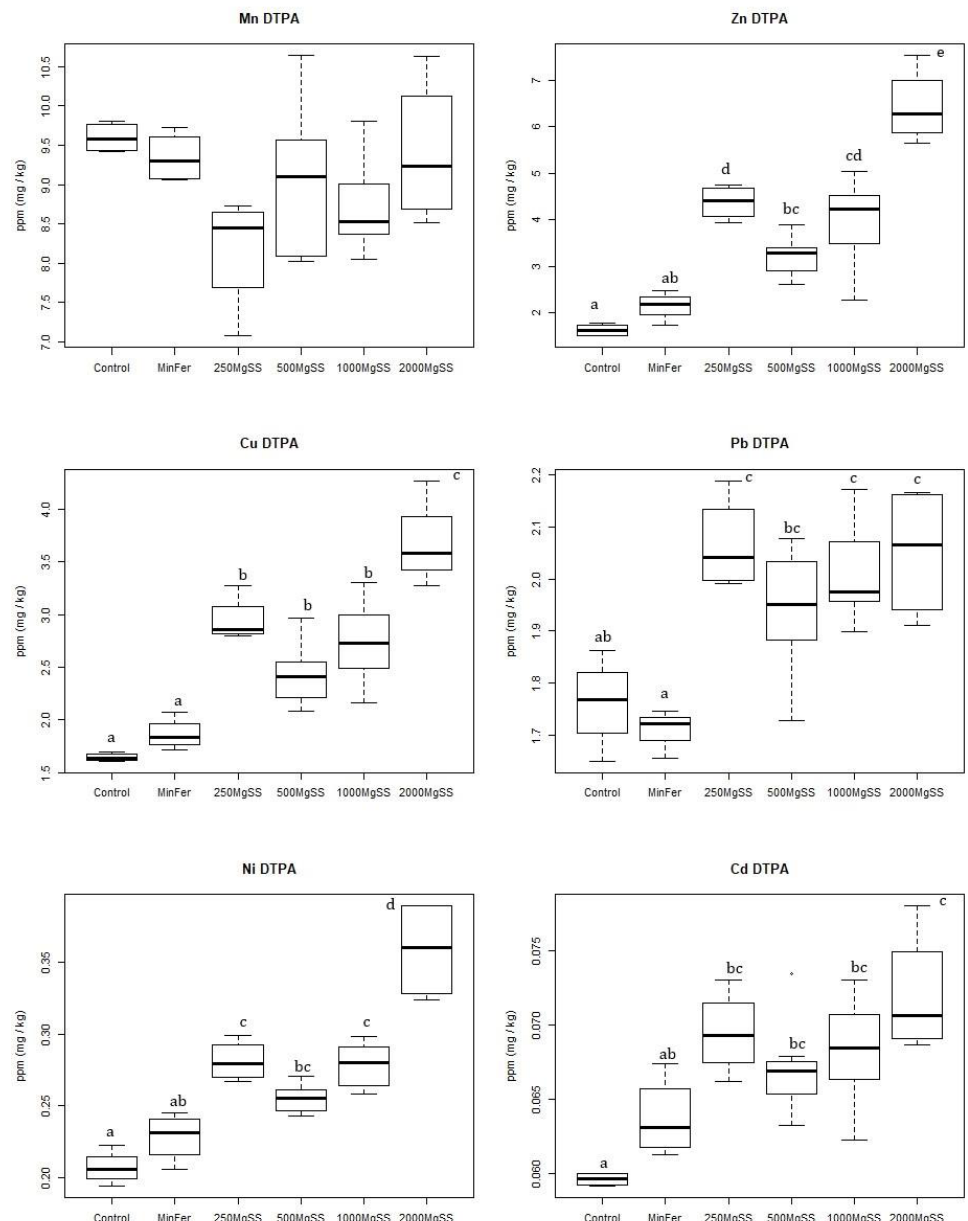
Figure 2. Box-and-whisker plots that indicate different homogeneous groups in the multiple comparison of means two to two of the concentration extracted by DTPA of the trace metal Mn, Zn, Cu, Pb, Ni and Cd existing in the soil according to the fertilizer treatment received in the study horizon (0–30 cm). Values showing the same letter belong to the same homogeneous group according to Tukey´ s test ( p < 0.05).